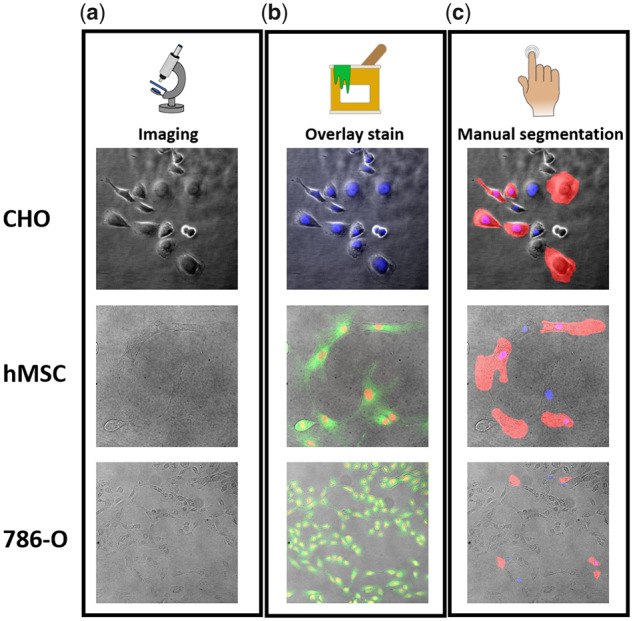
Dataset preparation pipeline. (a) Acquisition of BF and PhC microscopy images from various microscopes at different magnifications. (b) Overlay images of fluorescent nuclei and membrane, where available. (c) Manual segmentation of cell bodies (red) and nuclei (blue) were saved as binary masks and transformed into the COCO segmentation format. (Color version of this figure is available at Bioinformatics online.)